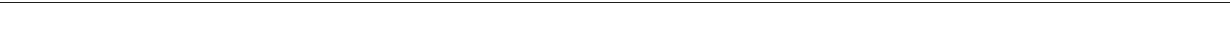
Fig. 2 Blnc1 is required for LXR-mediated lipogenic activation. a Plasma and liver TAG content from WT or Blnc1 KO mice receiving oral gavage of vehicle (Veh, open, WT, n = 4; KO, n = 3) or T0901317 (T1317, fi lled, WT, n = 3; KO, n = 4) for 4 days. b H&E staining of liver sections. Scale bar = 100 μ m. c qPCR analysis of hepatic gene expression. Data in ( a ) and ( c ) represent mean ± SEM. * p < 0.05, ** p < 0.01, *** p < 0.001, WT vs. KO, two-way ANOVA. d Immunoblots of total liver lysates and liver nuclear extracts. e qPCR analysis of gene expression in WT and Blnc1 KO hepatocytes treated with vehicle (Veh) or 5 μ M T1317 for 24 h. f Incorporation of 14 C-acetate into lipids in hepatocytes treated with Veh or T1317. Data in ( e , f ) represent mean ± SD ( n = 3). * p < 0.05, ** p < 0.01, *** p < 0.001, WT vs. KO, two-way ANOVA . g qPCR analysis of gene expression in hepatocytes transduced with GFP or Blnc1 adenovirus treated with Veh or 10 μ M SR9238 for 24 h. h Incorporation of 14 C-acetate into lipids in treated hepatocytes. Data in ( g ) and ( h ) represent mean ± SD ( n = 3). ** p < 0.01, *** p < 0.001, GFP vs. Blnc1, # p < 0.001, Veh vs. SR9238, two-way